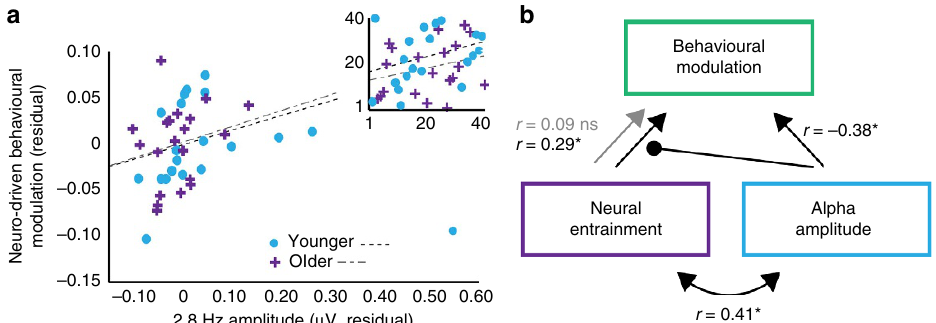
Figure 7 | Entrainment strength predicts neuro-driven behavioural modulation. ( a ) The partial correlation after partialling out alpha amplitude from the Pz electrode between 2.8Hz amplitude (averaged over a fronto-central electrode cluster: Fz, F3, F4, FC3, FC4, Cz, C3, C4) and neuro-driven behavioural modulation was significant. Plot shows residuals, that is, deviations of the neuro-driven behavioural modulation observations from the fitted function characterizing the relationship between alpha amplitude and neuro-driven behavioural modulation, plotted against the residuals from the correlation between alpha amplitude and 2.8Hz amplitude. Best-fit lines are shown separately for younger and older groups. Line for younger group excludes the extreme data point marked with arrow. ( b ) Schematic representation illustrating the statistical interaction between neural entrainment, alpha amplitude and behavioural modulation. Behavioural modulation was significantly predicted by neural entrainment strength, but only when alpha amplitude was partialled out. Inset shows ranks on which Spearman correlation was based. X axis shows ranks on 2.8Hz amplitude residuals, and y axis shows ranks on neuro- driven behavioural modulation